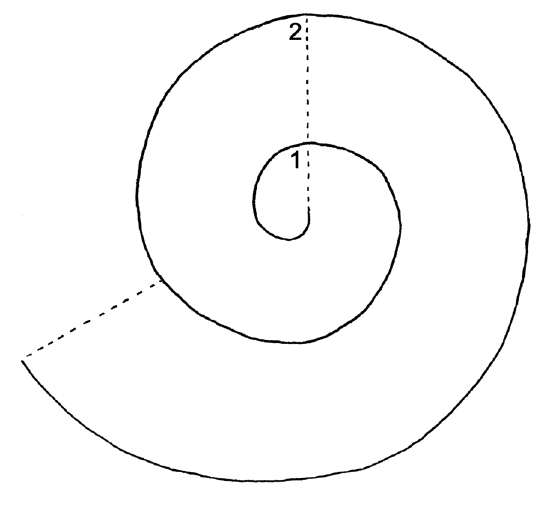
Fig. 3. Diagram illustrating method for measuring protoconch